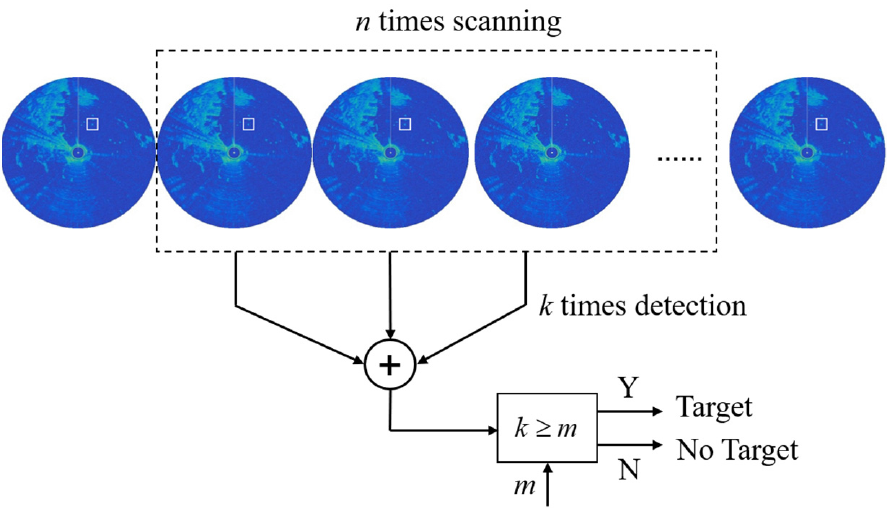
Figure 7. The flowchart of multi-frame fusion for sea clutter false alarms reduction.